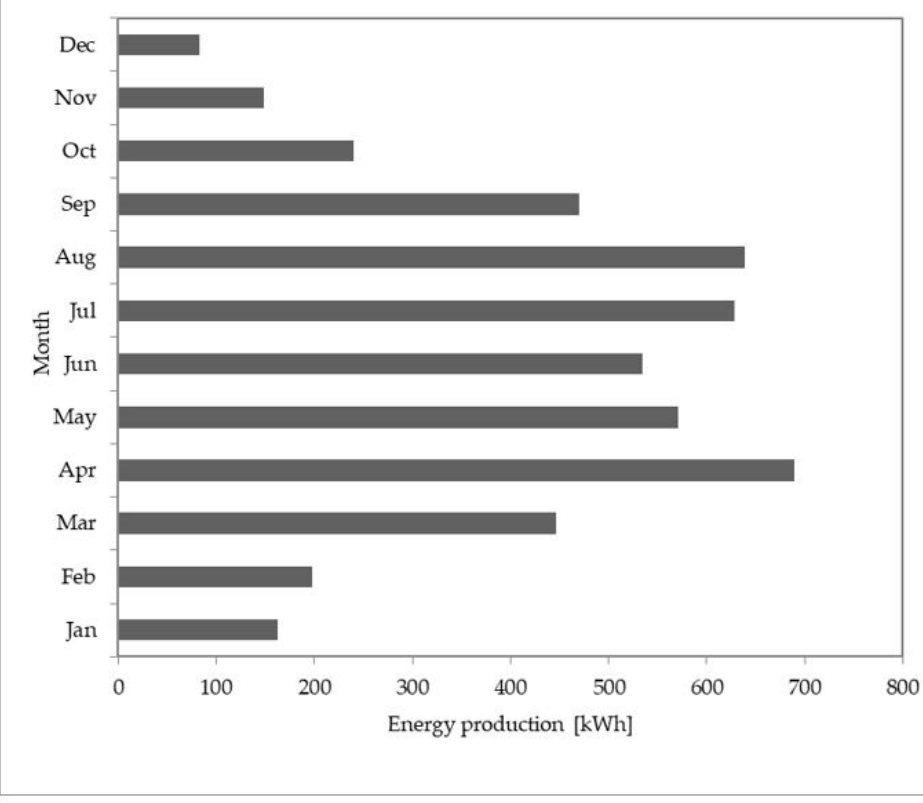
Figure 10. Actual energy production by the photovoltaic installation in 2020.